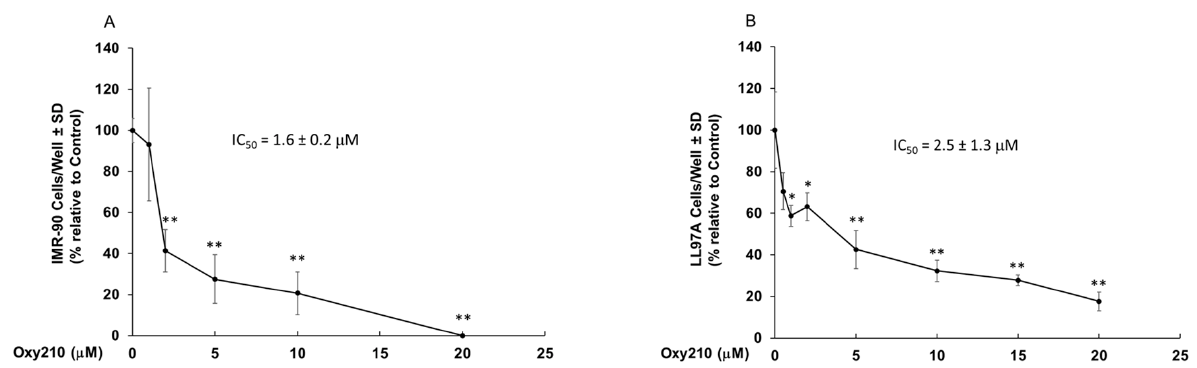
Figure 3. Oxy210 inhibits proliferation of IMR-90 and LL97A cells. IMR-90 ( A ) or LL97A ( B ) were treated with Oxy210 as indicated in DMEM or F12K containing 5% FBS, respectively, for 6 days and then were trypsinized and counted. Data from a representative experiment are reported as the mean of triplicate determinations ± SD (* p < 0.05 vs. control; ** p < 0.01 vs.